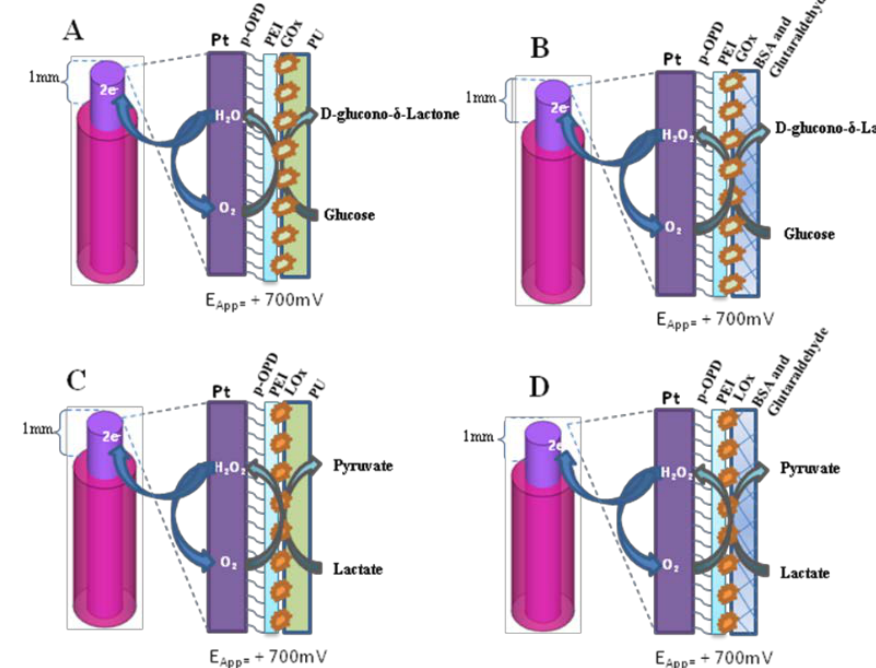
Figure 1. Graphical representation of two main designs of glucose and lactate biosensors used in this study: GB1 (Panel A): Pt c /PPD/[PEI(0.5%)-GOx] 5 /PU (5%); GB2 (Panel B): Pt c /PPD/[PE(0.5%)- GOx] 5 /GTA(1%)-BSA(2%); LB1 (Panel C): Pt c /PPD/[PEI(0.5%)-LOx] 5 /PU (5%); LB2 (Panel D): Pt c /PPD/[PEI(0.5%)-LOx] 5 / GTA(1%)-BSA(2%); Pt c : Pt cylinder 1 mm long, 125 μm diameter; GOx: glucose oxidase; LOx: lactate oxidase PPD: poly-ortho-phenylenediamine; PEI: polyethyleneimine; PU: polyurethane; GTA: glutaraldehyde; BSA: bovine serum albumin. The subscript “x” represents